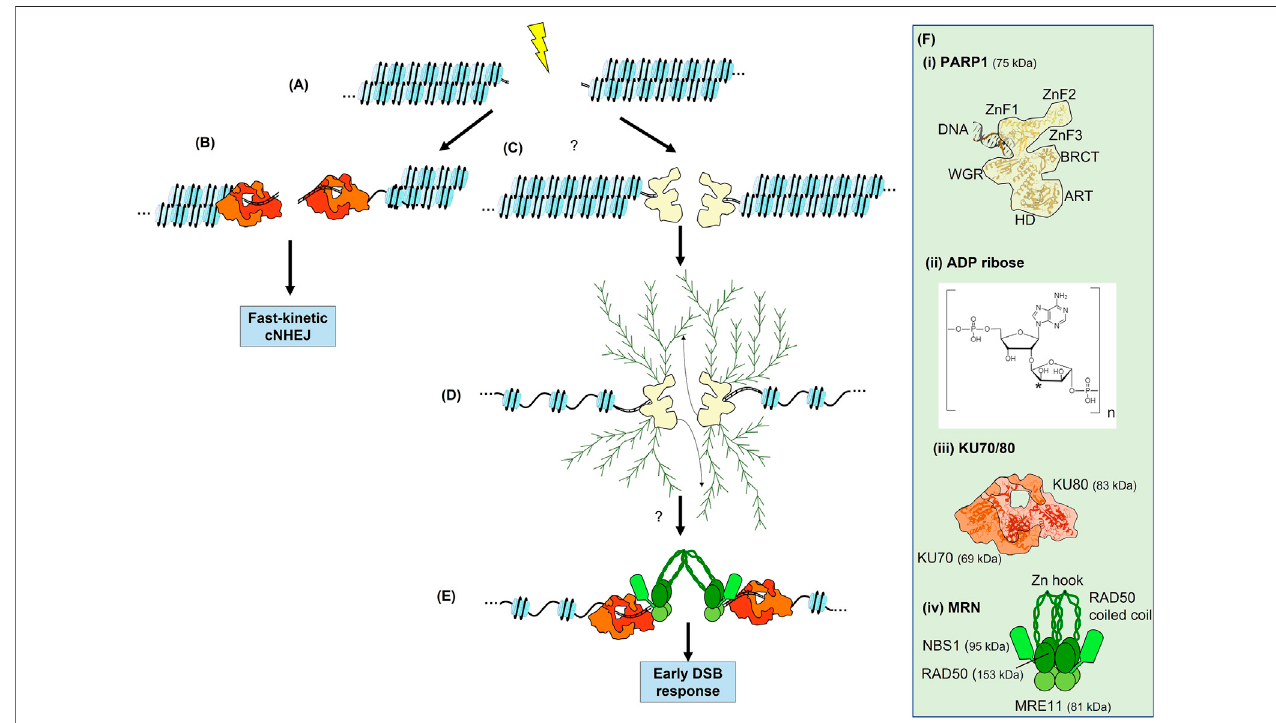
FIGURE 2 | The Immediate-Early response to a DSB. (A) Generation of a DSB within a chromatin fi bre. (B) Recruitment of KU70/80 to some breaks. If KU70/80 is recruited and the break is easily ligatable, fast-kinetic cNHEJ can occur. (C) The recruitment of poly(ADP-ribose) polymerases (PARP) to some DSBs. (D) Expansion of linearandbranchedchainsofpolyADPribose(PAR)onPARPresultsinchromatindecondensation.PARylationofotherproteinsoccursbutisnotshown.PARylationisa highly dynamic process involving reversal of PARylation by poly(ADP-ribose) glycohydrolase (PARG, not shown). Many DNA repair proteins are recruited to both PARP and PAR chains. The involvement of PARP in the DSB response is not fully elucidated. (E) Recruitment of both KU70/80 and MRN are promoted by PARP and PARylation at some DSBs. Initial recruitment of these complexes to the vicinity of the DSB is via interaction with PAR, subsequently they directly bind DSB ends and contribute to synapsis. KU70/80 appears to be recruited with faster kinetics than MRN and is required for fast-kinetic cNHEJ during the Immediate-Early response as seenin (B) .Notethatboth KU70/80and MRNarerequired forslow-kineticcNHEJ but KU70/80mustbeevicted priortoMRN-dependentHR. (F) StructuresofPARP1, ADP-ribose, KU70/80 and MRN. Where known, structure is superimposed within overall architecture as illustrated. (i) PARP1, the N-terminal zinc fi ngers, ART, HD and WGRdomainsofPARPareindicated(seetextfordetails),aswellastheinteractionwithaDSB(LangelierandPascal,2013;Beeketal.,2021).TheinteractionwithHPF1 is not shown. (ii) ADP-ribose, linear chains are polymerised via the phosphate groups, whereas the asterisk indicates the position of at which branched chains are attached (Drenichev and Mikhailov, 2016). (iii) KU70/80 heterodimer shown in shades of red (Walker et al., 2001). (iv) MRN complex in shades of green with the coiled- coils of RAD50 extending outwards (Williams et al., 2009; Casari et al., 2019). In (D) these coiled-coils interact via their zinc